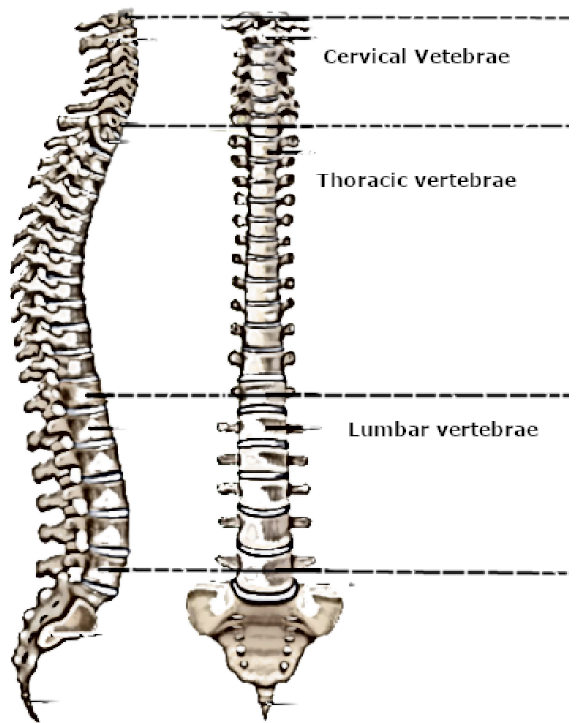
Figure 1. Human vertebral